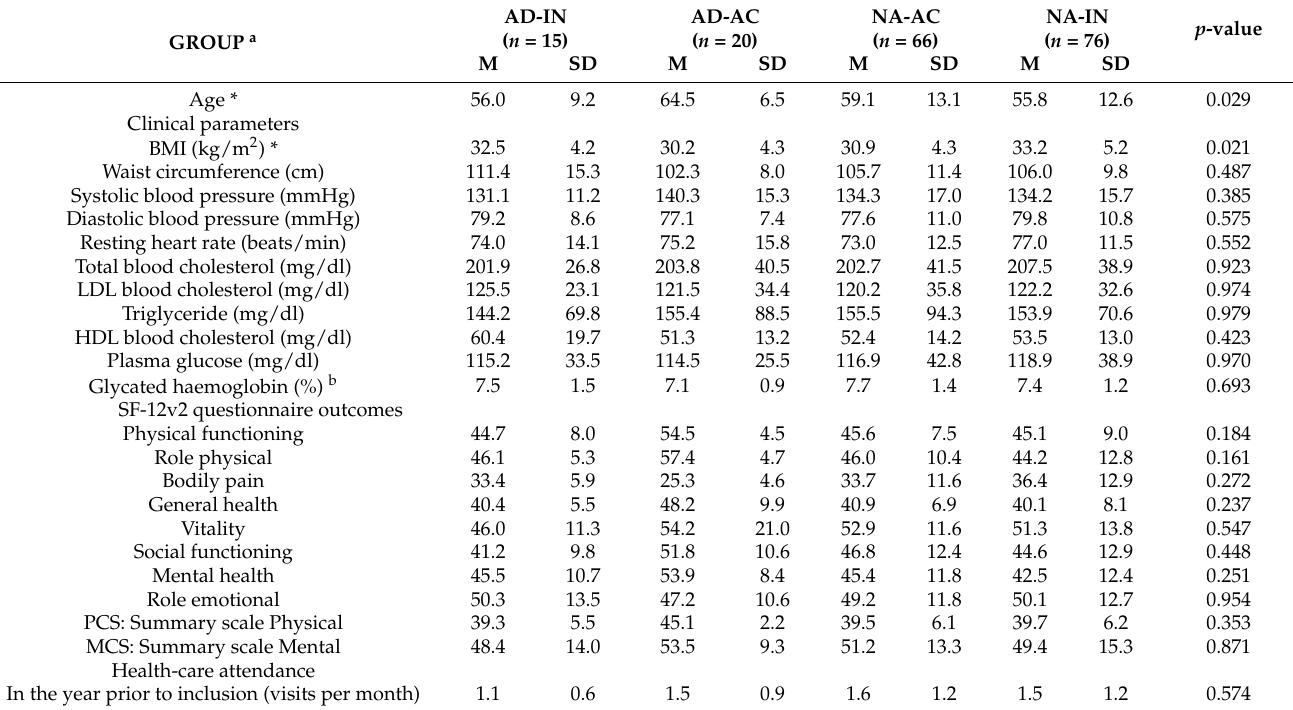
Table 3. Homogeneity for continuous variables at baseline among groups.